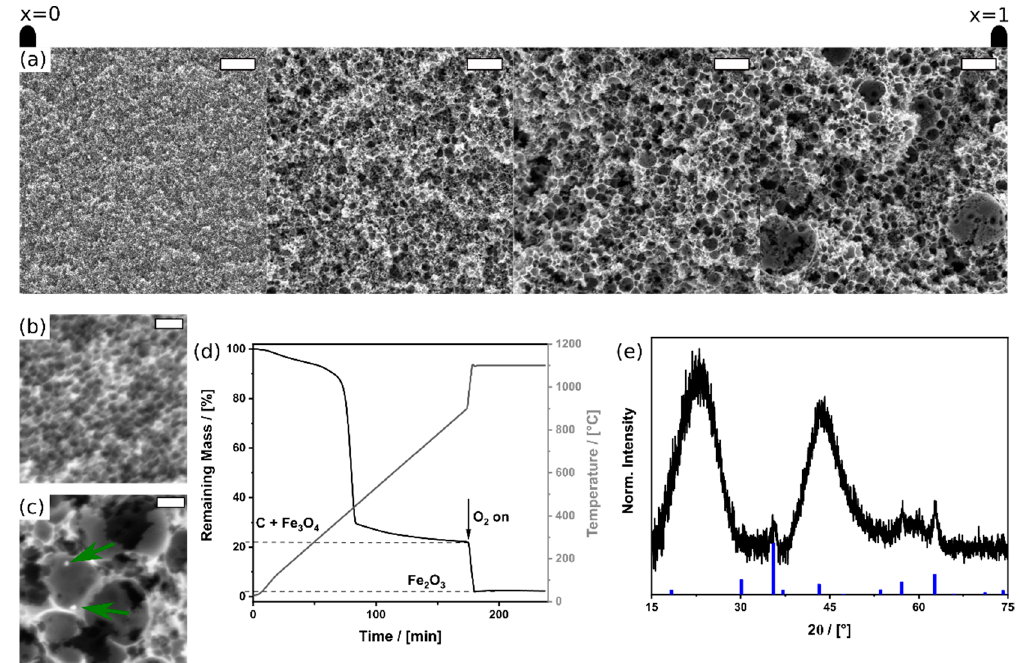
Figure 4. Analysis of a gradient porous Mag@C material with additional magnetite gradients. ( a ) SEM micrographs taken along the direction of the centrifugal force (scale bar: 1000 nm). Enlarged SEM micrographs (scale bar: 200 nm) at ( b ) x → 0 (left side of the gradient region) and ( c ) x → 1 (right side of the gradient region), arrows in ( c ) indicating magnetite nanoparticles. ( d ) TGA showing the carbonization process under nitrogen atmosphere and subsequent decomposition under oxygen atmosphere and isothermal conditions. TGA trace given in black, temperature given in gray. ( e ) PXRD measurements of homogenized Mag@C with magnetite reference (COD: 2101926) given in blue.